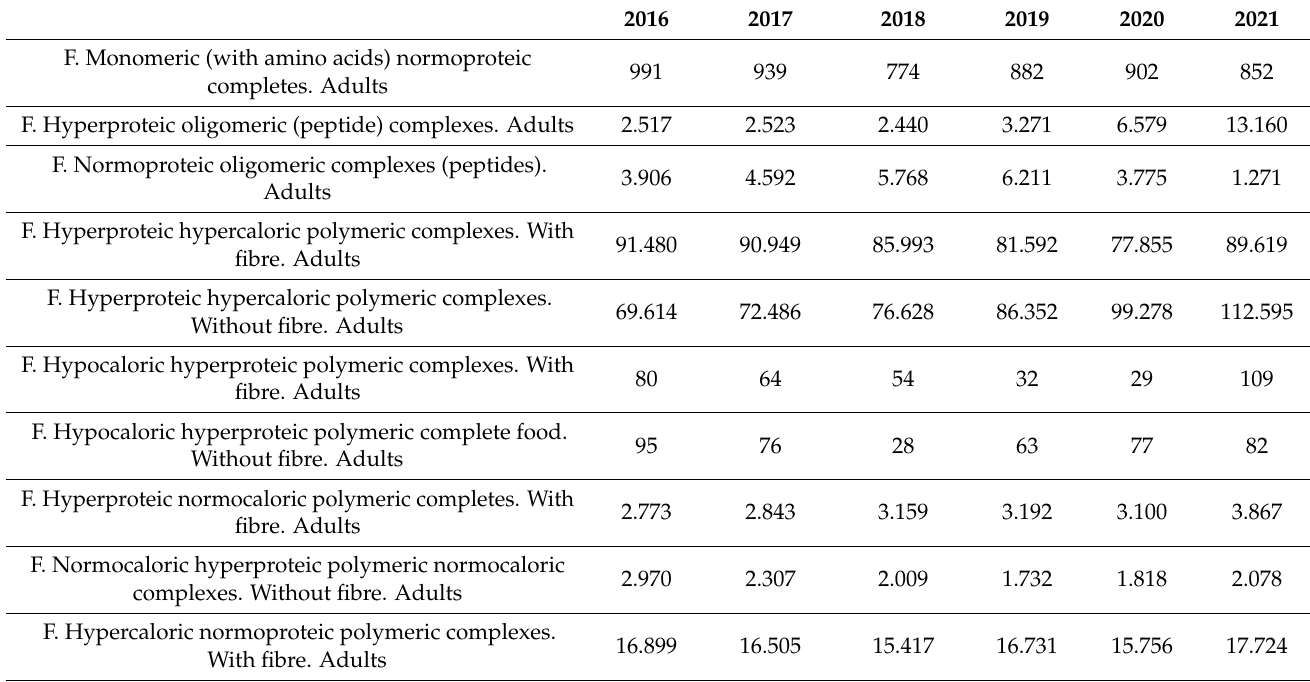
Table 1. Packaging consumption of different types of high-protein and normoprotein diets from 2016 to